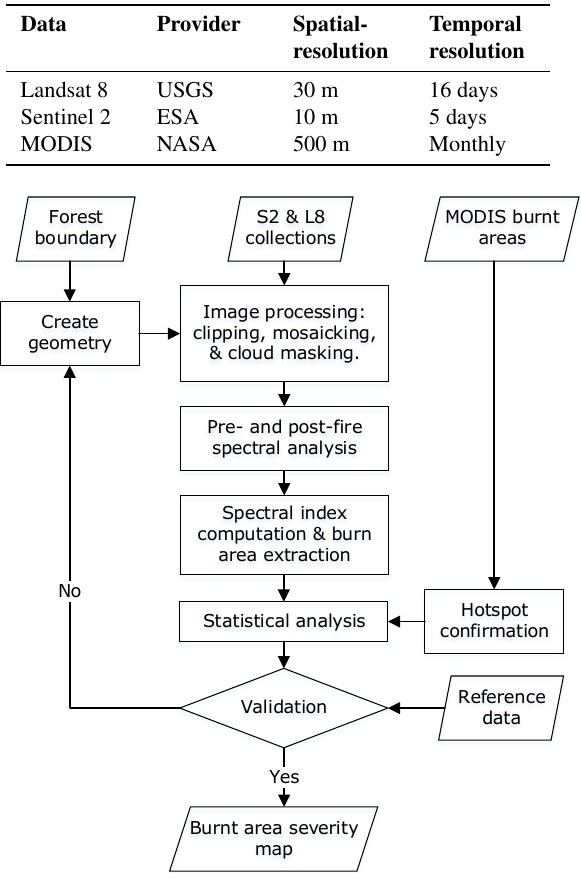
Table 1. Data and data Sources